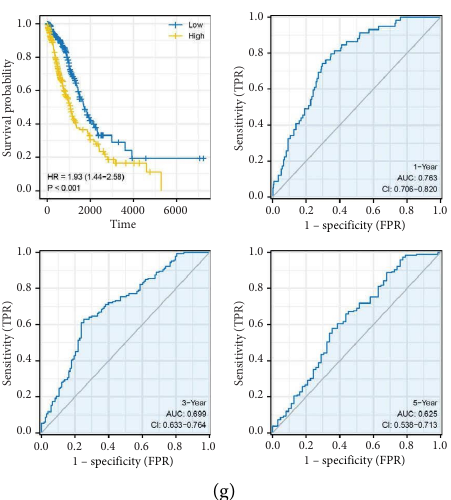
Figure 3: Construction and validation of prognosis signature. (a and b) LASSO regression of input genes; (c) multivariate Cox regression based on the genes identifed by LASSO regression; (d) overview of the risk score in the training cohort; (e) KM survival and ROC curve of high- and low-risk patients in the training cohort; (f) overview of the risk score in the validation cohort; (g) KM survival and ROC curve of high- and low-risk patients in the validation